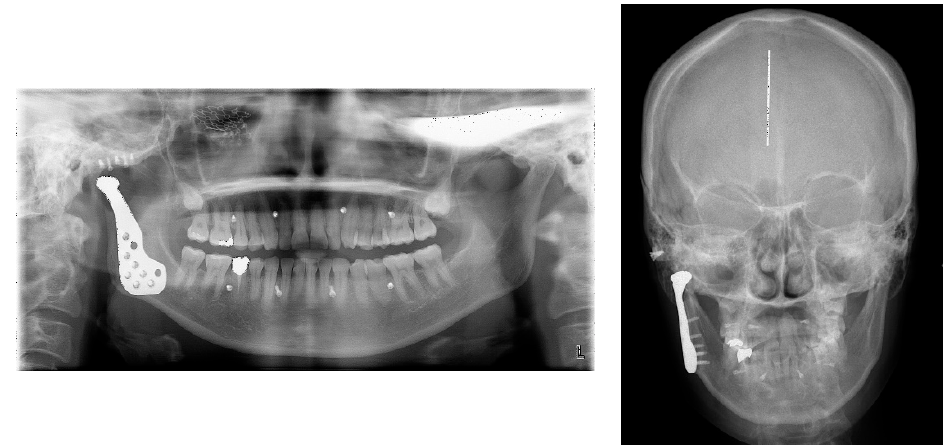
Figure 2. Representative post-operative radiographs at the first day after surgery.